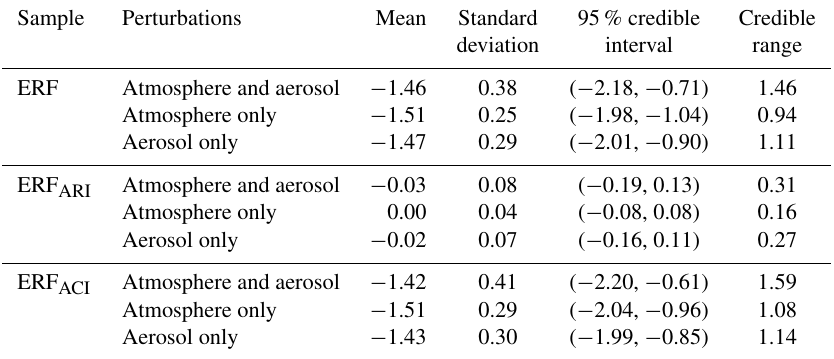
Table 2. Summary statistics for the pdfs of 1850–2008 aerosol ERF, ERF ARI and ERF ACI presented in Fig. 1. Perturbations to atmospheric and/or aerosol parameters cause the uncertainty in model output in each case. All values are in watts per metre (Wm − 2 ). For all samples the null hypotheses of equivalent means or standard deviations are rejected at the 99% confidence level using Welch’s t (Welch, 1947) and Bartlett (Snedecor and Cochran, 1989) tests